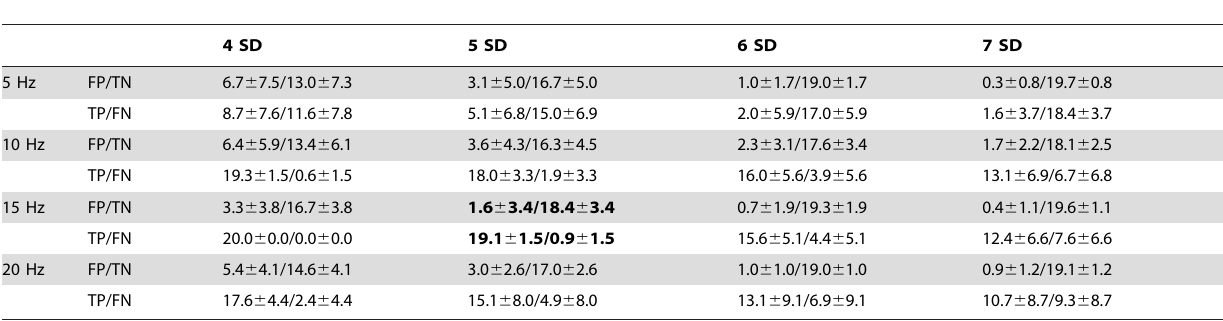
Table 1. Optimization of BCI